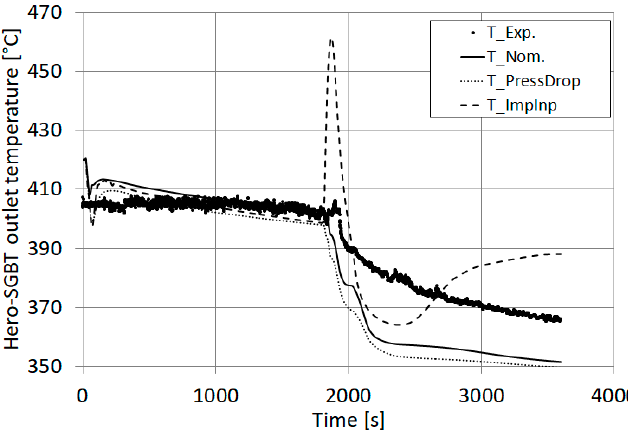
Figure 8. HERO- Steam Generator Bayonet Tube (SGBT) outlet temperatures. Comparison between experimental values and numerical results obtained under different conditions.